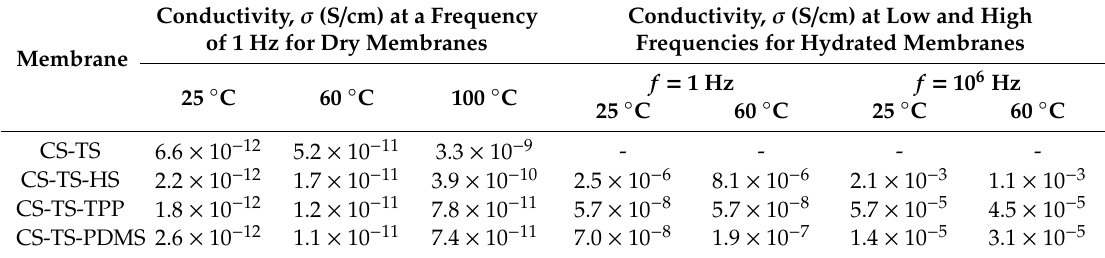
Table 2. Values of conductivity at various frequencies for dry and hydrated chitosan-sulfated titania